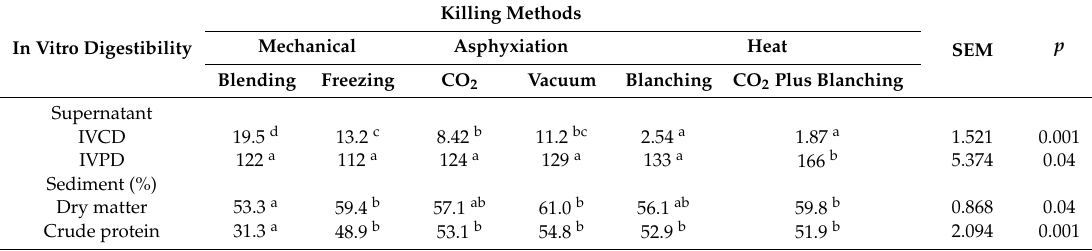
Table 3. In vitro digestibility of BSF larvae meal as raw